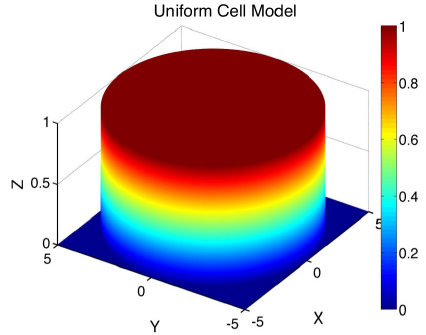
Figure 3. Illustration of the spatial component, δ radius (cid:15) = 5 µm.